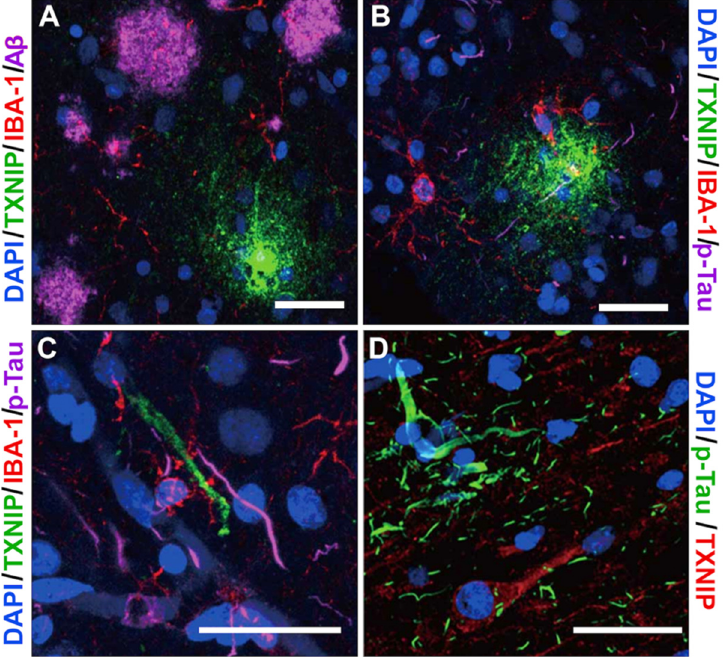
Figure 10. Interactions of TXNIP with pathological features in middle temporal gyrus ( A – C ). Triple staining demonstrating TXNIP (green), IBA-1 (red), and A β (A, purple) or p-Tau (B–C, purple). ( D ) Absence of colocalization of p-Tau (green) and TXNIP (red). Bars represent 30 μ m.